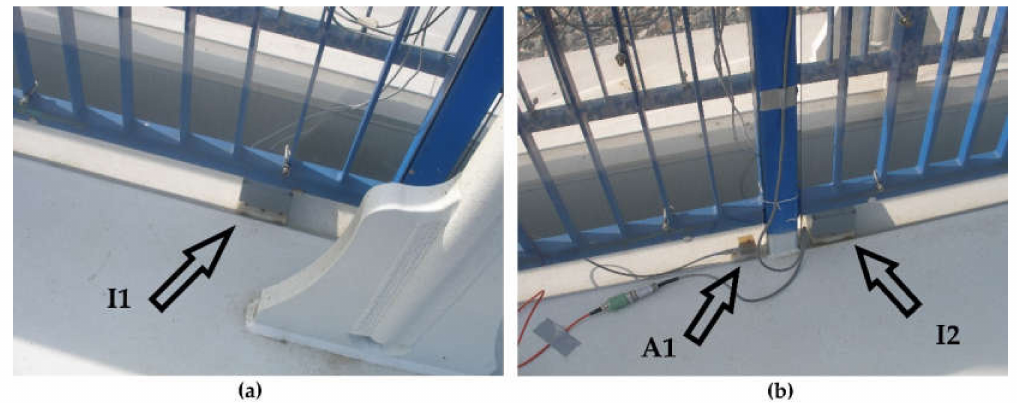
Figure 5. View of inclinometers and accelerometer location: ( a ) Inclinometer I1 location; ( b ) accelerometer A1, and inclinometer I2 location.